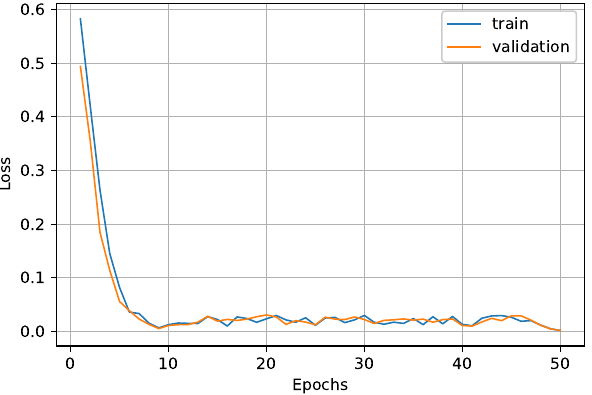
Figure 10. Autoencoder network learning loss—categorical crossentropy.